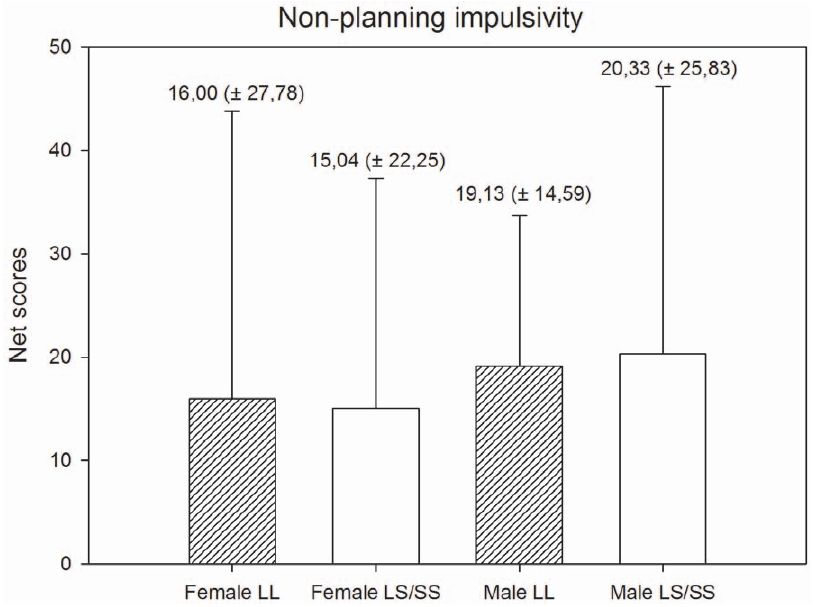
Figure 3. Non-planning impulsivity scores and standard deviation of scores by gender and genotype.